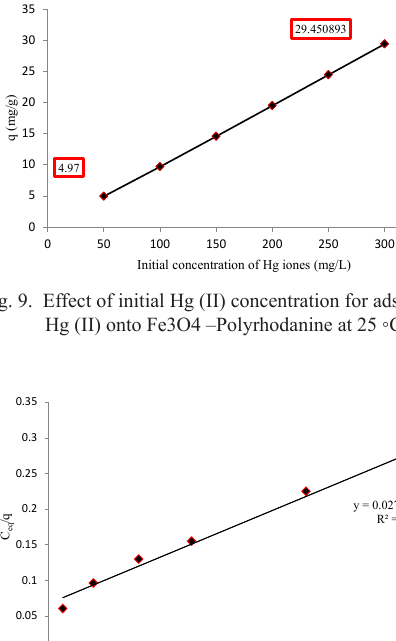
y = 0.0273x + 0.0678 R²=0.9874